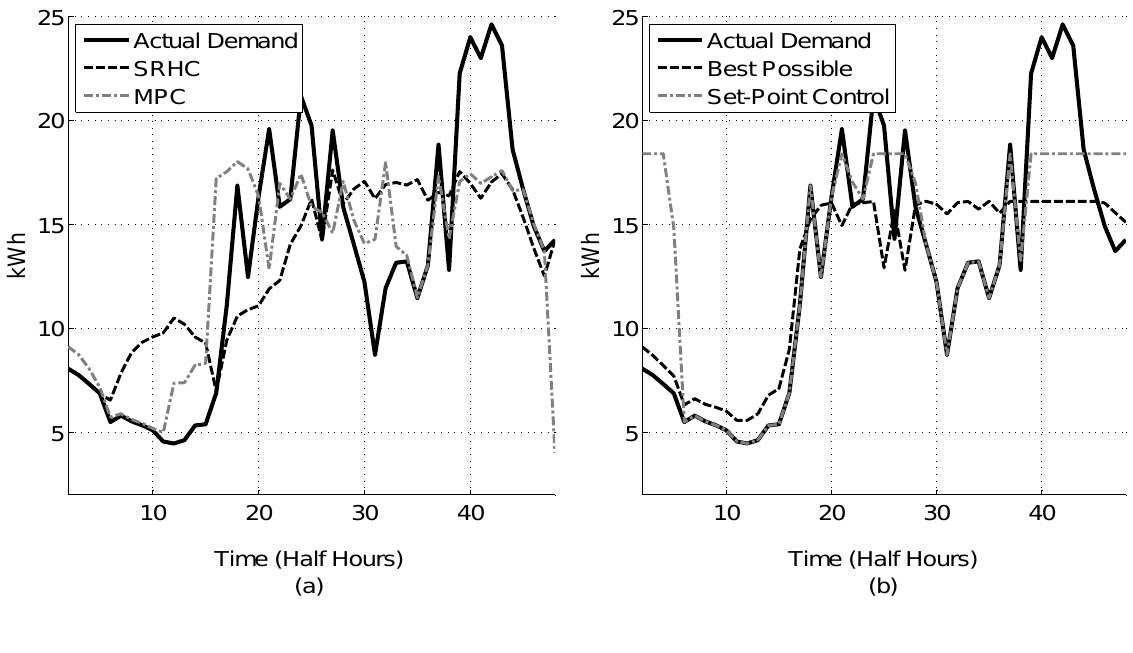
Figure 4. A specific example: ( a ) the actual demand and the stochastic receding horizon controller (SRHC) and MPC controller results; ( b ) the actual demand and the best possible and set-point controller